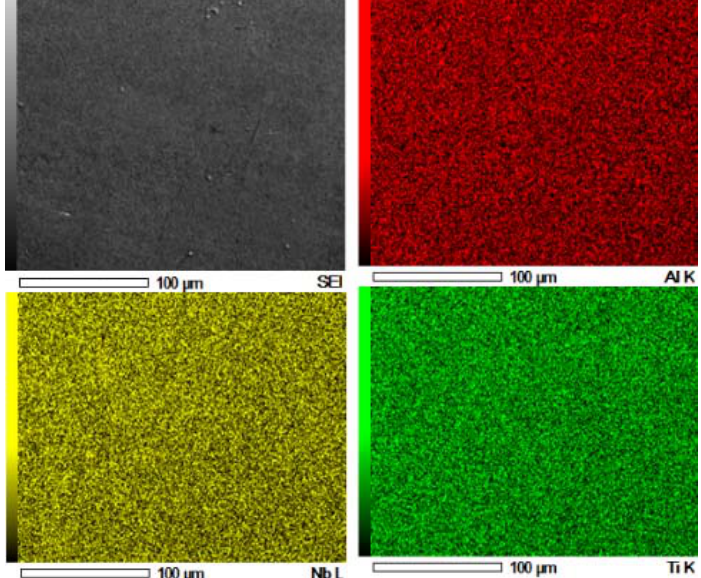
Figure 2. EDS map of synthesized Ti-Al-xNb (A1) at 0.052 g/min Nb feed rate.